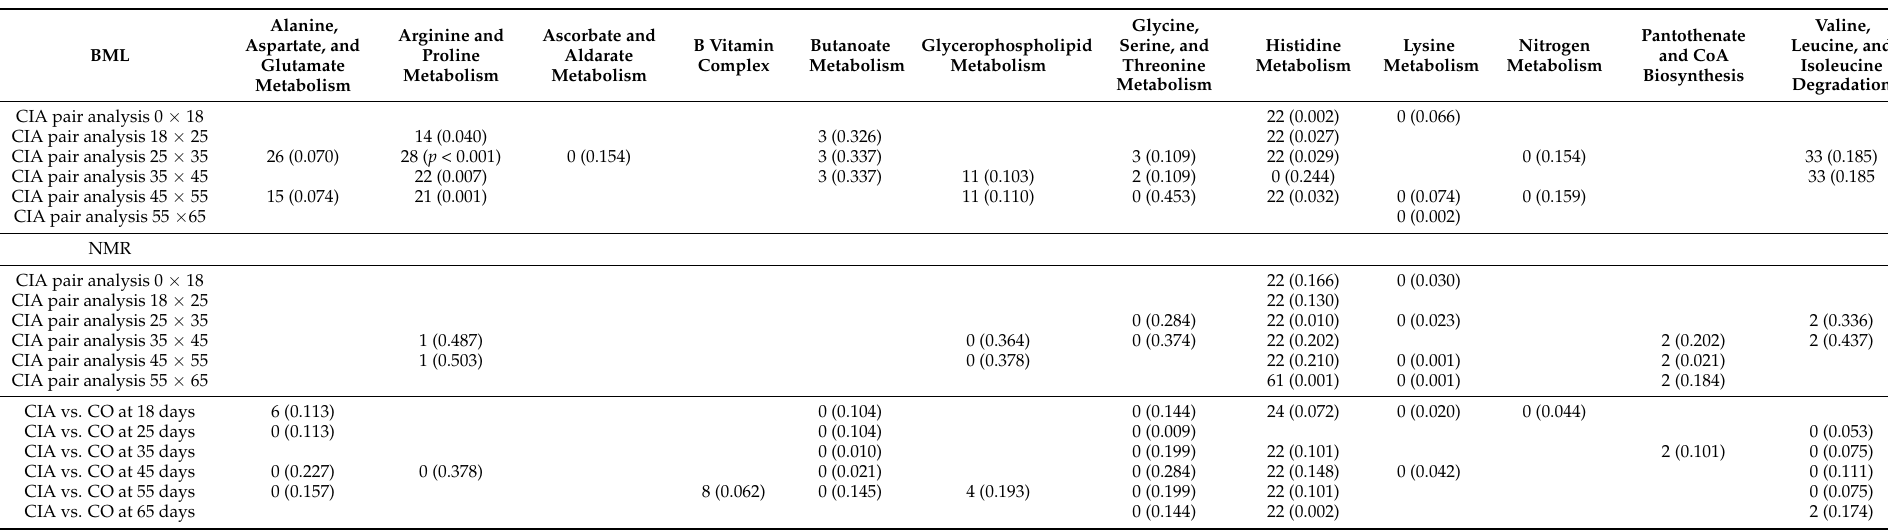
Table 3. Metabolic pathway analysis of metabolite ranking data from PLSDA models comparing CIA vs. CO at each time-point and CIA pair analysis at each time. Data expressed as “% of metabolic pathway impact ( p